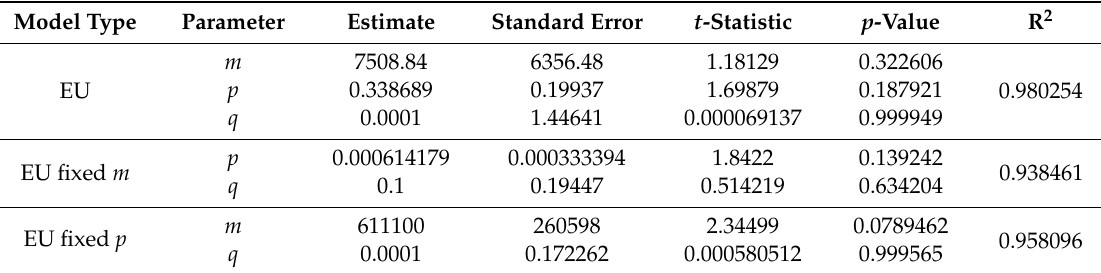
Table 4. Estimation of Bass model parameters for EU [Source: own study based on data retrieved from